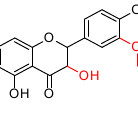
Figure 4. Structures of discussed flavanonols.